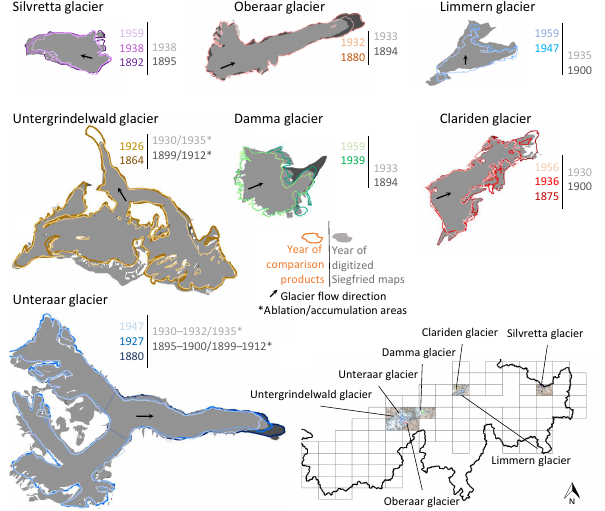
Figure 4. Comparison of the digitized outlines of the Siegfried map for seven glaciers with contemporary products from other sources. later editions, corresponding better to the glacier area from the 1850 product.